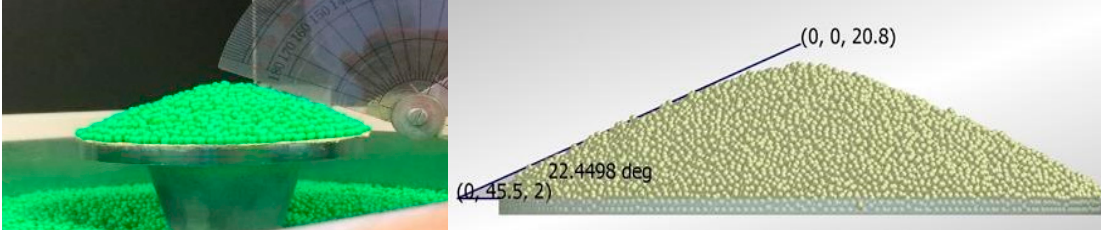
Figure 2. Natural slope forming: experimental set-up on the left and simulated equivalent on the right.